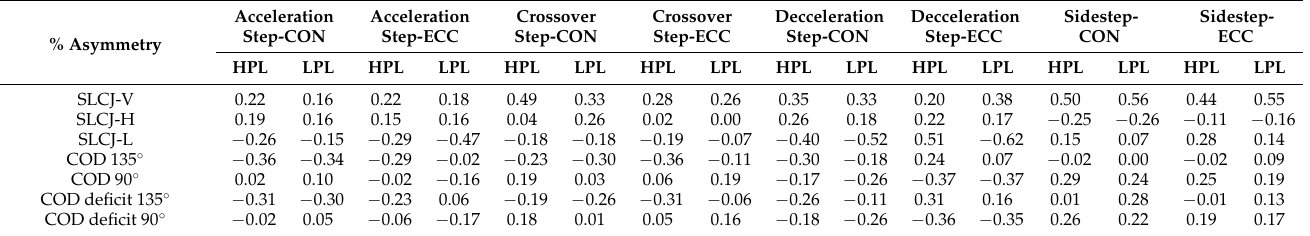
Table 3. Spearman’s r correlations between inter-limb asymmetry scores and flywheel resistance